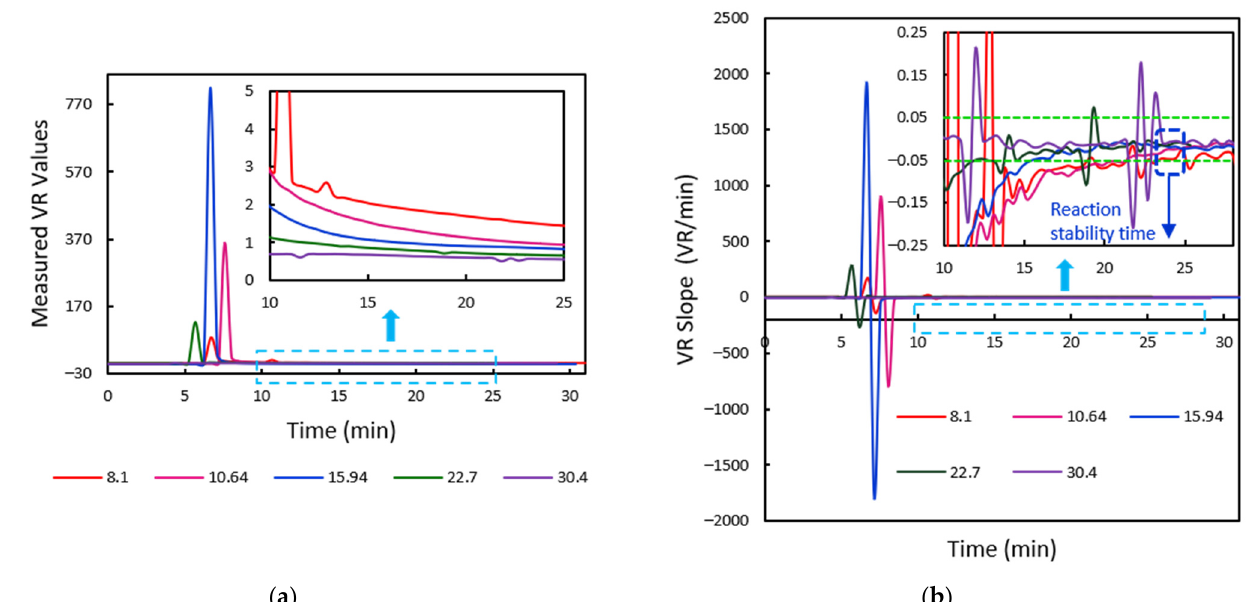
Figure 18. ( a ) The volume ratio values measured for 5 Vitamin D test cartridges of different concentrations. The inset image indicates the zoomed-in VR graph from time t = 10 min to t = 25 min. ( b ) The corresponding trend of change in VR slopes with time, the zoomed graph from time t = 10 min to t = 28 min, is depicted.